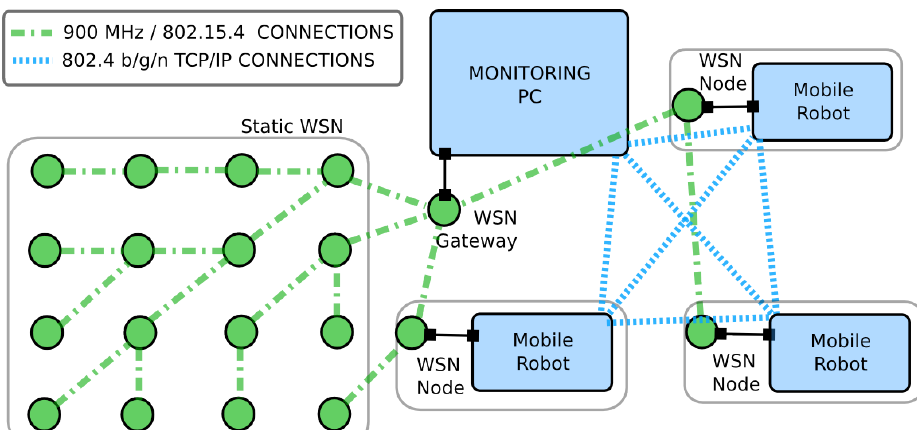
Figure 4. Connections among the testbed